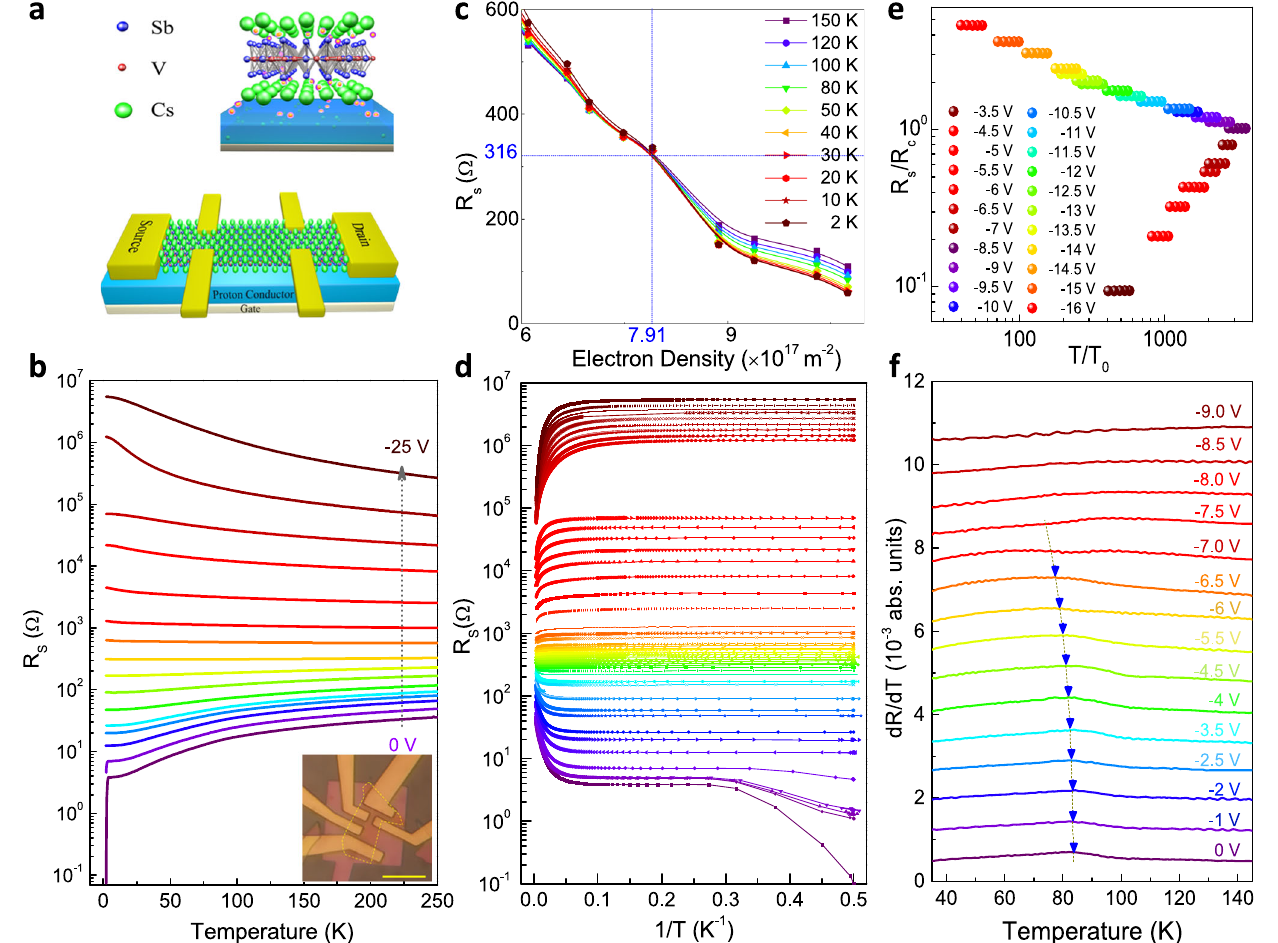
Fig. 1 | Temperature-dependent longitudinal resistance curves under various gating voltages in device #5 (21nm). a Schematic of proton gating on CsV 3 Sb 5 nano fl akes (upper) and Hall-bar device (lower). b Temperature dependence of sheet resistance at various gate voltages in device #5. c Sheet resistance as a function of charge densityn e near SIT.ThecriticalresistanceR c ~ 316 Ω is obtained with carrier density n c ∼ 7 : 91×10 17 m (cid:2) 2 . d Sheet resistance as the function of 1/T